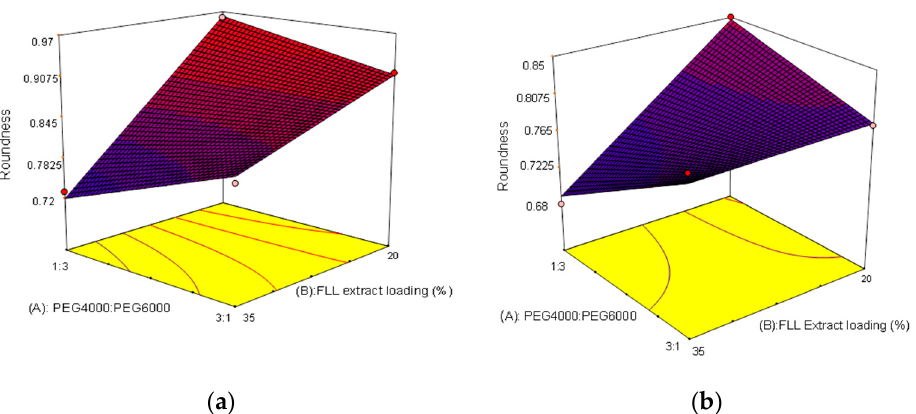
Figure 8. Using a 2 3 factorial experimental design to evaluate the significant effects of the interaction between ratio of PEG 4000/PEG 6000 (A) and FLL extract loading (B) on roundness under different Tween 80 concentrations ( p < 0.05). ( a ) 5% Tween 80 ( b ) 15% Tween 80 .